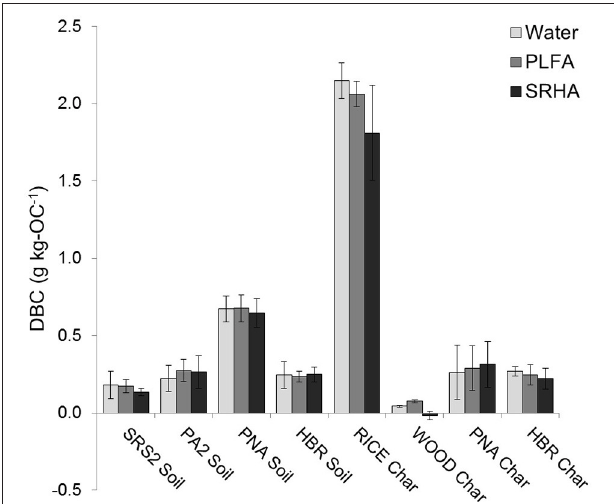
FIGURE 4 | Net DBC leached from soils and chars with water, PLFA, and SRHA (error bars = 1